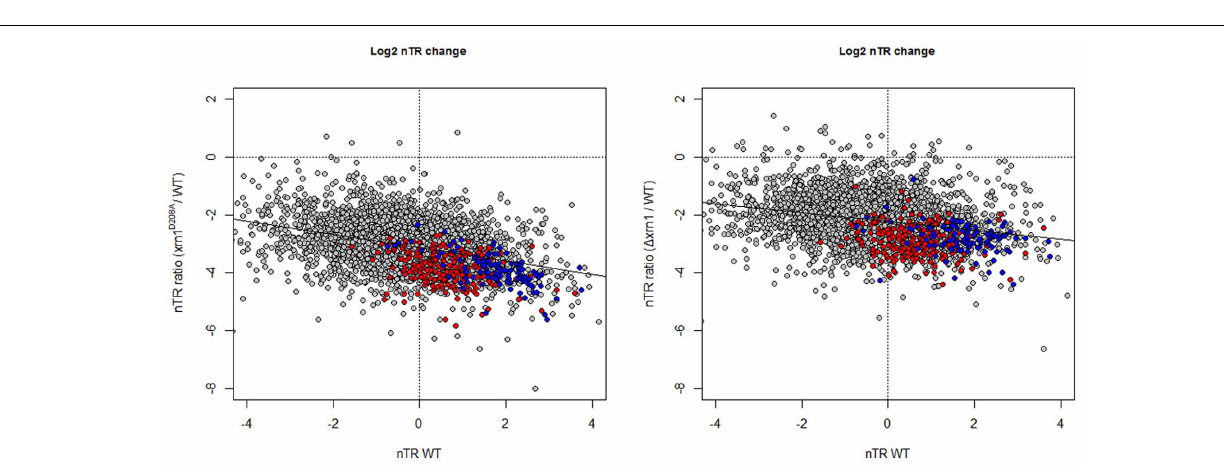
was defined arbitrarily as 1 (0 on the Log 2 scale). Note that the ratios obtained for most genes are negative, indicating that the transcription in the mutant was lower than in the wt counterpart. See Figure 1 for other